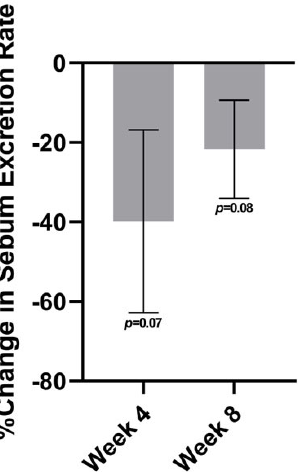
Figure 4. The sebum excretion rate at week 4 and at week 8 relative to baseline on the forehead.